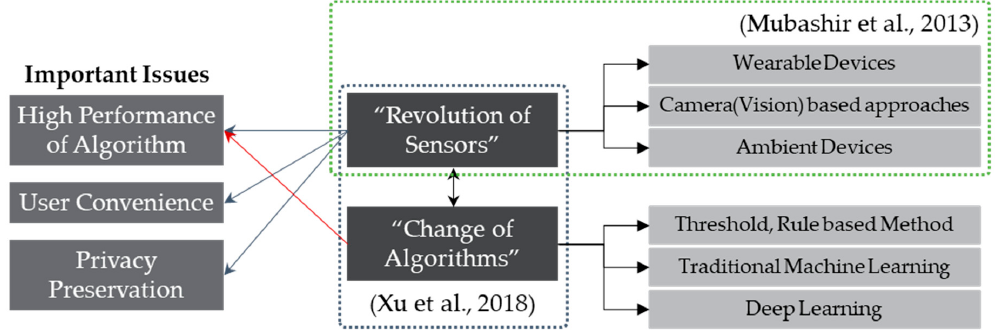
Figure 1. Classification of key issues and research topics related to fall detection.